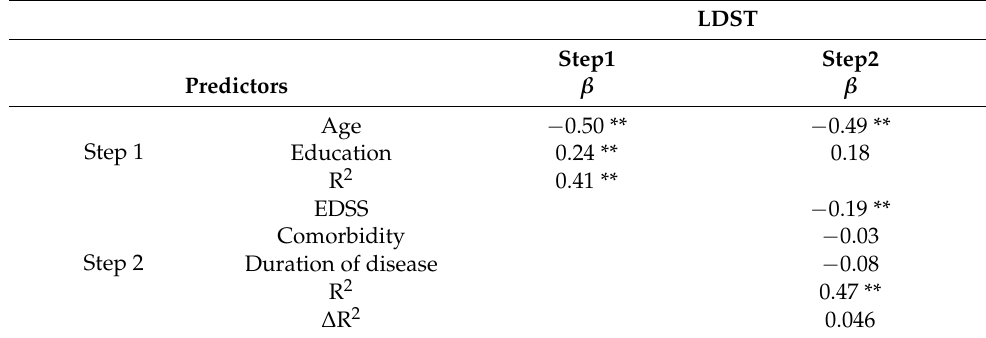
Table 5. Multiple hierarchical regression analysis for the impact of age, sex, education, and EDSS score on LDST performance of